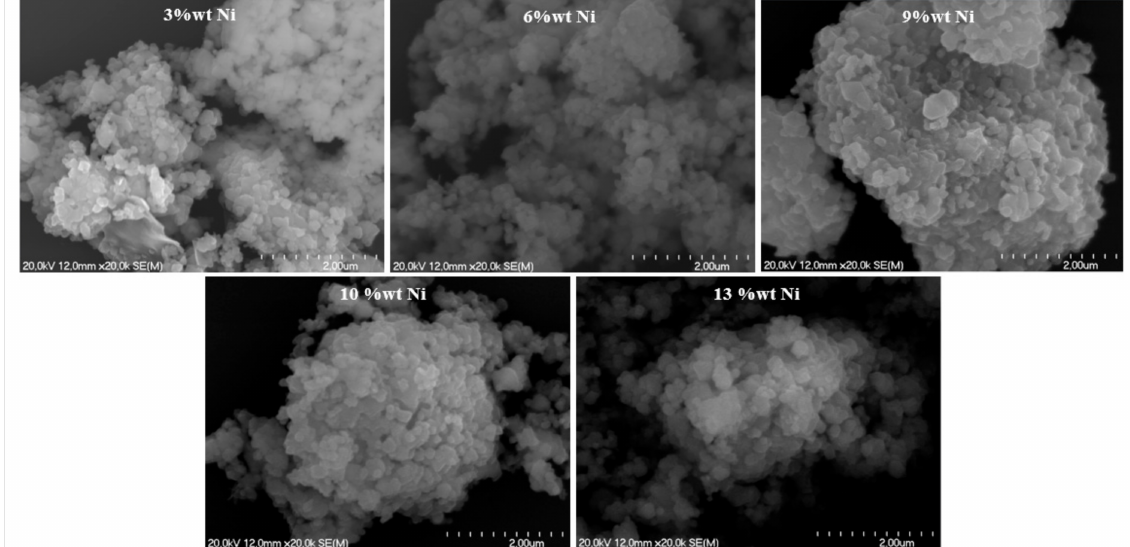
Figure 3. SEM photos of the Ni-UGSO catalyst as a function of